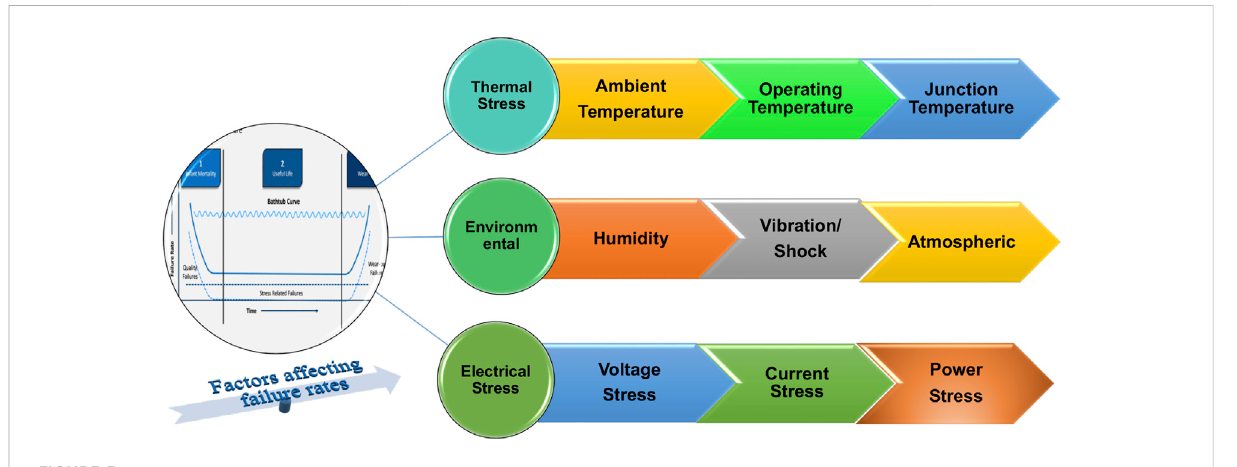
FIGURE 5 Environmental factors which lead to component